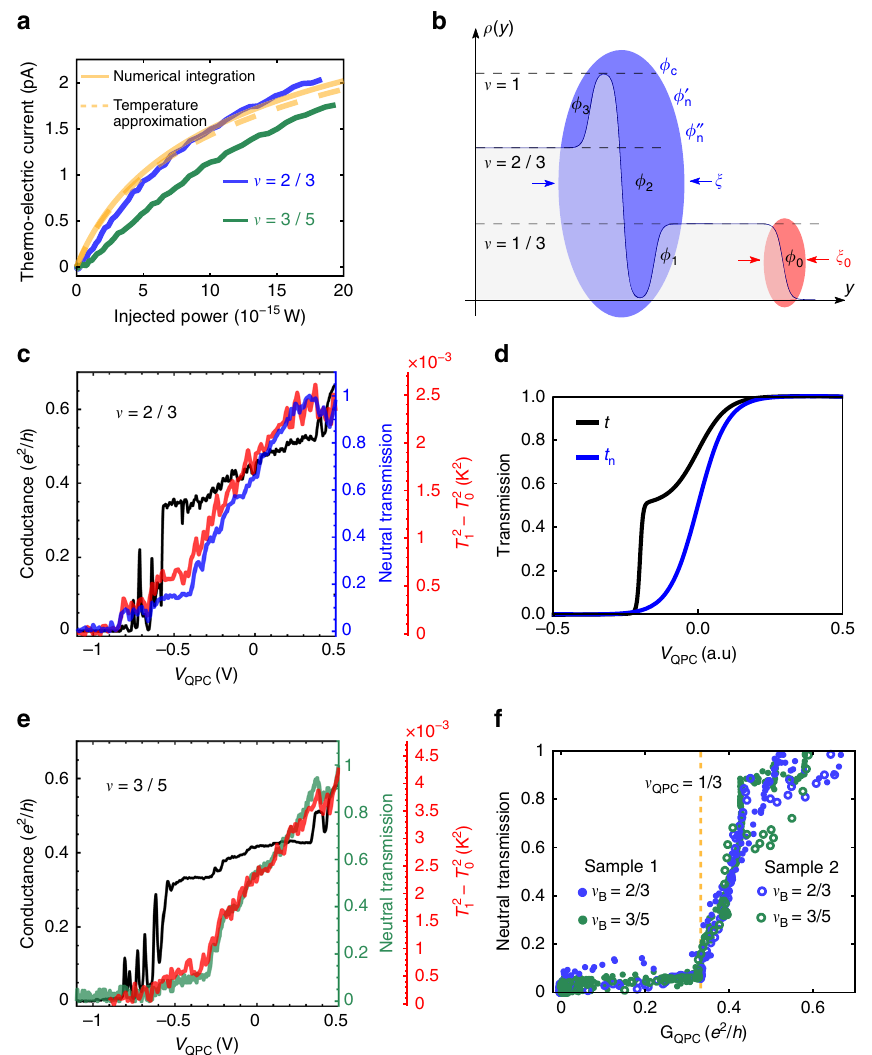
Fig. 2 Transmission of neutral modes. a Evolution of the thermoelectric current as function of the Joule power applied on H at ν = 2/3 (blue curve) and at ν = 3/5 (green curve). Theoretical prediction of the thermoelectric current through the QD, orange dashed curve shows effective temperature approximation, orange solid curve shows result of exact numeric integration. b Theoretical model of the edge structure of the ν = 2/3 state. Before equilibration four charge modes, ϕ 0,1,2,3 are considered with respective velocity set by ∂ ρ ( y )/ ∂ y . After renormalization, the system consists of two downstream charge modes of different width ξ and ξ 0 and two upstream neutral modes attached to the inner mode. c Black curve – left axis: Conductance at the QPC constriction as function of the QPC split gate voltage at ν = 2/3, blue curve – right blue axis: Evolution of the neutral transmission as function of the QPC split gate voltage. Red curve – red axis: evolution of the temperature of the neutral modes, measured using excess noise at D1 as function of the QPC split gate voltage. d Theoretical charge and neutral transmission. e Similar to c at fi lling factor ν = 3/5. f Neutral transmission as function of the conductance in the QPC constriction for the bulk fi ling factors ν B = 2/3 and ν B = 3/5. The plain and open symbols designate two different